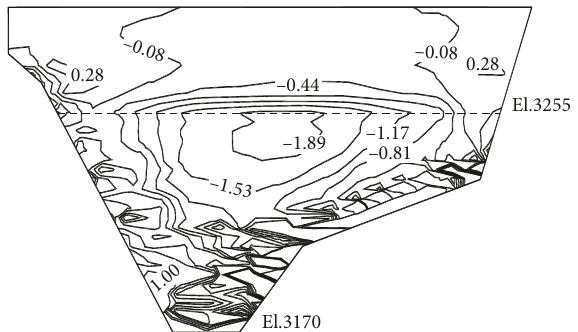
Figure 16: Shear stress in the concrete face under condition 2 with the water level at 3283m (units: MPa).